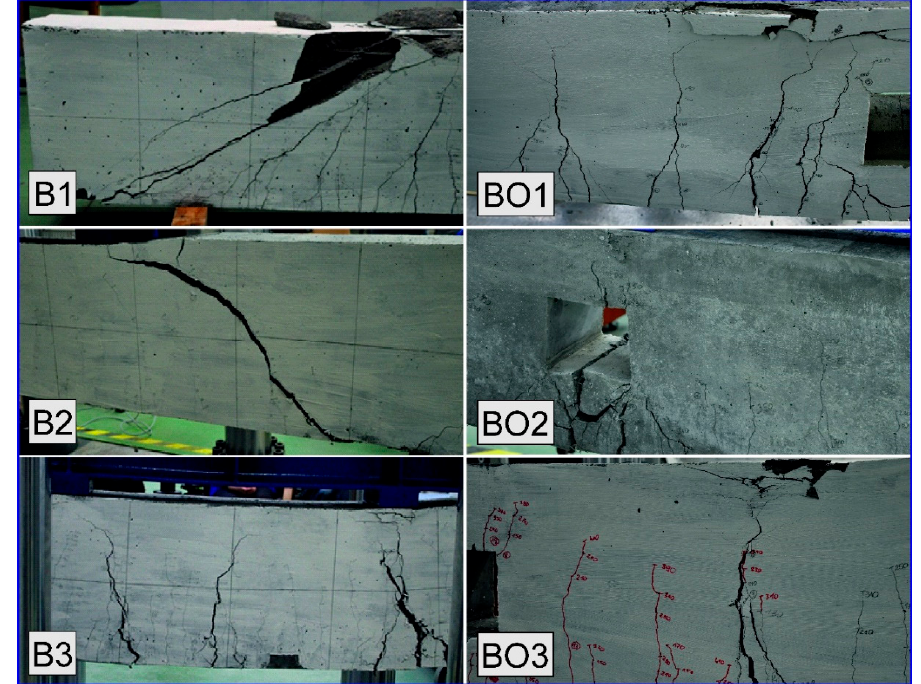
Figure 7. Beams failure modes.